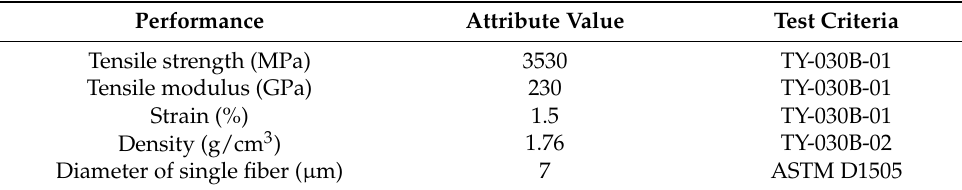
Table 3. Carbon fiber performance parameters (T300).